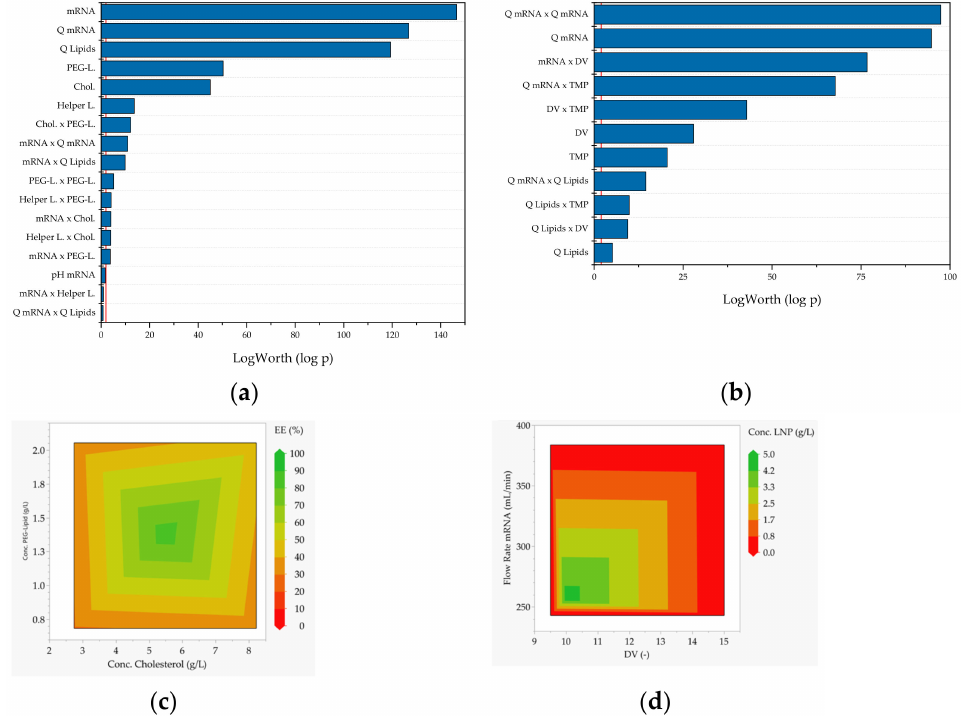
Figure 25. Effect strengths (a log-worth >2 is defined as significant) of factors on ( a ) encapsulation efficiency and ( b ) LNP concentration, and contour plots of ( c ) encapsulation efficiency with factors PEG lipid concentration and cholesterol concentration and ( d ) final LNP concentration with factors flow rate and transmembrane pressure